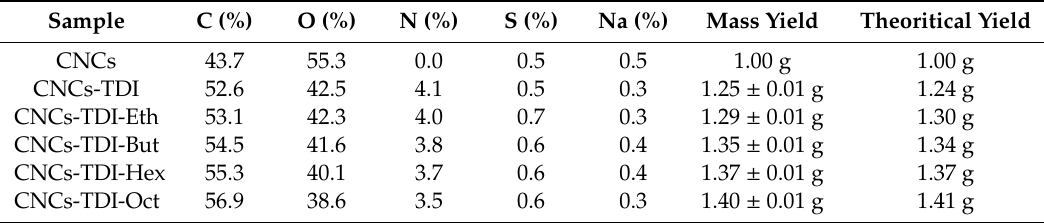
Table 1. Monitoring the change in the elemental composition of CNCs before and after surface modification and the resulting increase in mass